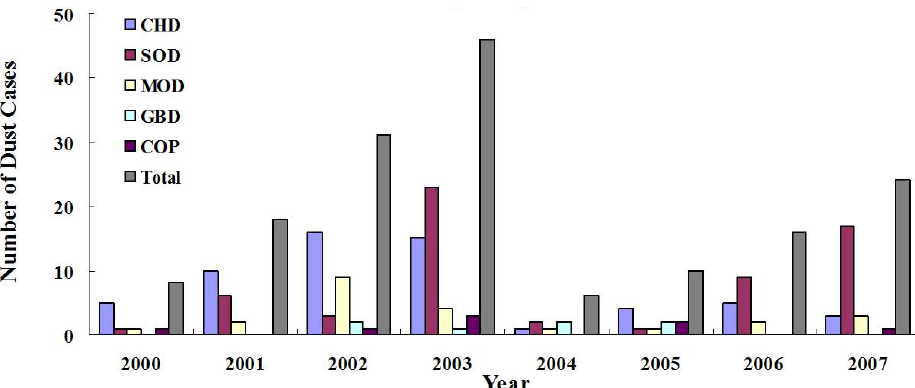
Fig. 6. The annual frequency of local dust cases from 2000 to 2007 in the five dust source regions, namely, the Chihuahuan Desert (CHD), the Sonoran Desert (SOD), the Mojave Desert (MOD), the Great Basin Desert (GBD) and the Colorado Plateau